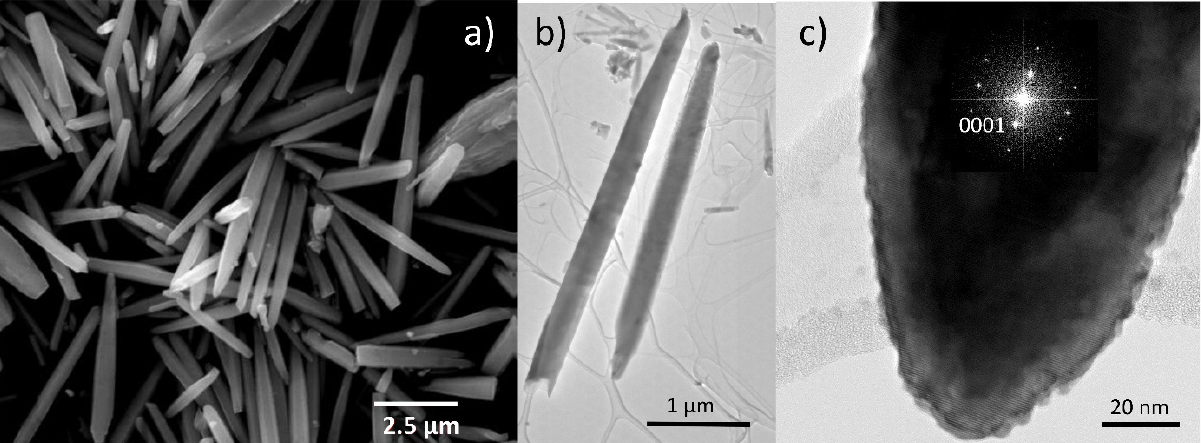
Figure 2. Morphological analyses: ( a ) FESEM image of dispersed ZnO MRs; ( b ) TEM image of two ZnO MRs; ( c ) HRTEM image of the ZnO MR grown along the polar c -axis and located on the right-hand side of ( b ). The corresponding FFT image is depicted as an inset.